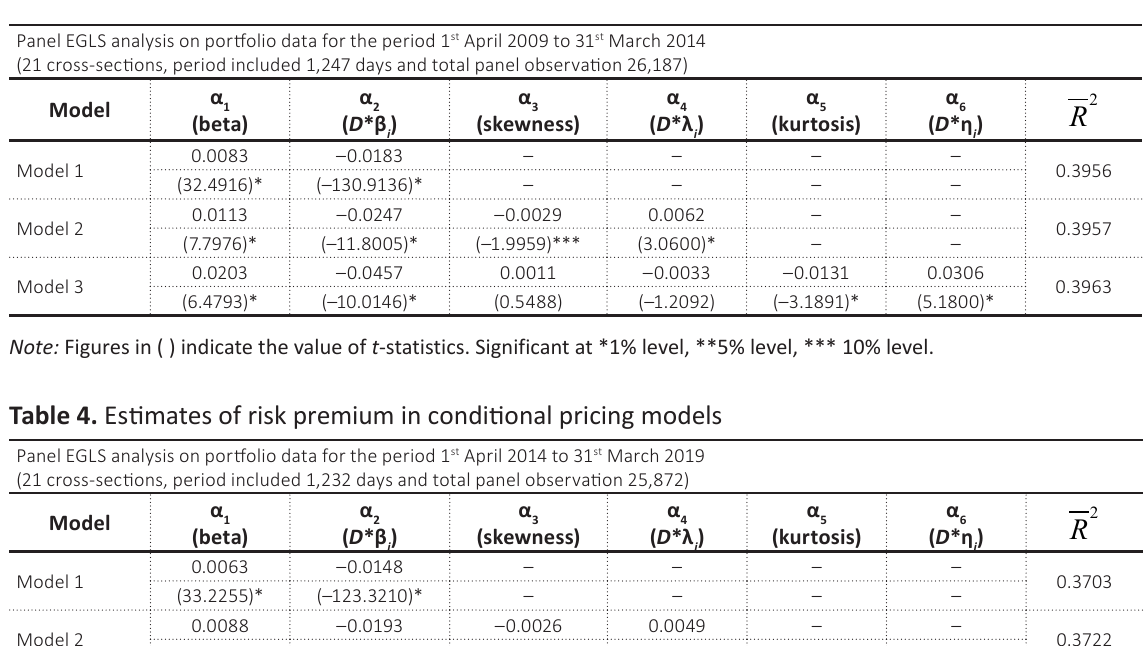
Table 3. Estimates of risk premium in conditional pricing models